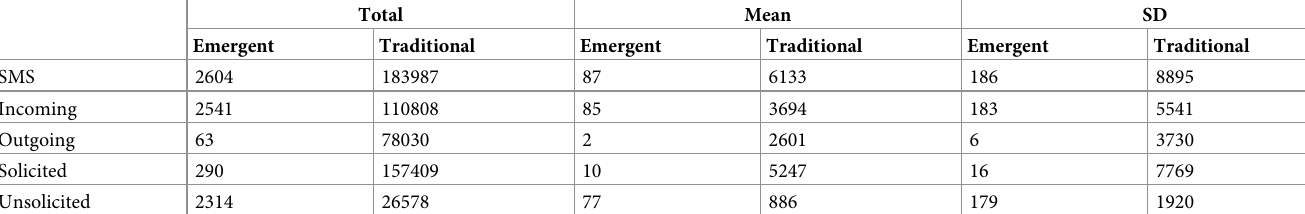
Table 4. Summary of main features of emergent and traditional user’ SMS logs including total number of texts, incoming texts, out going texts, total solicited texts, and the total number of unsolicited texts. Emergent users had a mean number of 87 (s.d 186) total text records including 10 (s.d 16) solicited texts. Whereas, traditional users had a mean number of 6133 (s.d 8895) total texts including a mean number of 5247 (s.d 7769) solicited text messages. Similarly, the mean number of outgoing texts of emergent users came out to be 2 (s.d 6) which is very low as compared to that of traditional users i.e. 2601 (s.d 3730).